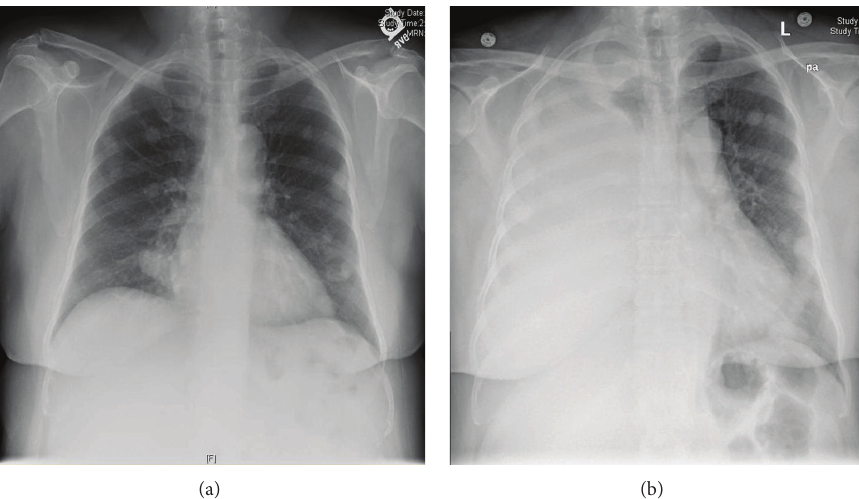
Figure 1: (a) CXR taken two years before presentation. (b) CXR at the time of presentation shows a white-out of the right